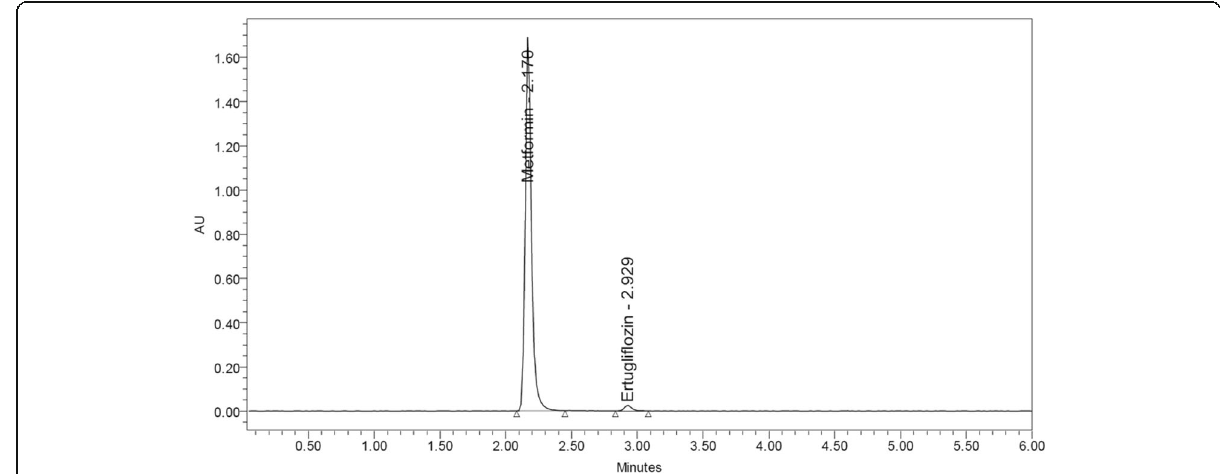
Fig. 4 Optimized chromatogram of ERTU and MET